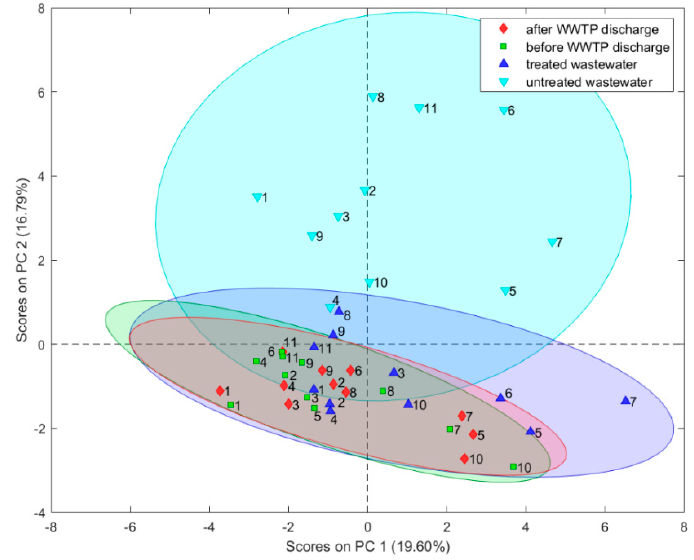
Figure 4. PC1 vs. PC2 factor scores plot. Figure 5 represents the grouping of samples according to PC1 and PC3 factor scores.